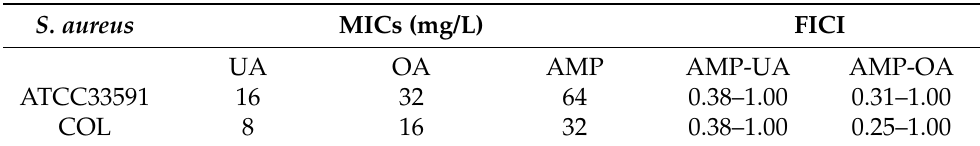
Table 1. Antimicrobial activity of ursolic acid (UA), oleanolic acid (OA) and ampicillin (AMP) on MRSA strains and FIC index (FICI; Fractional Inhibitory Concentration Indices) of their combinations. N =